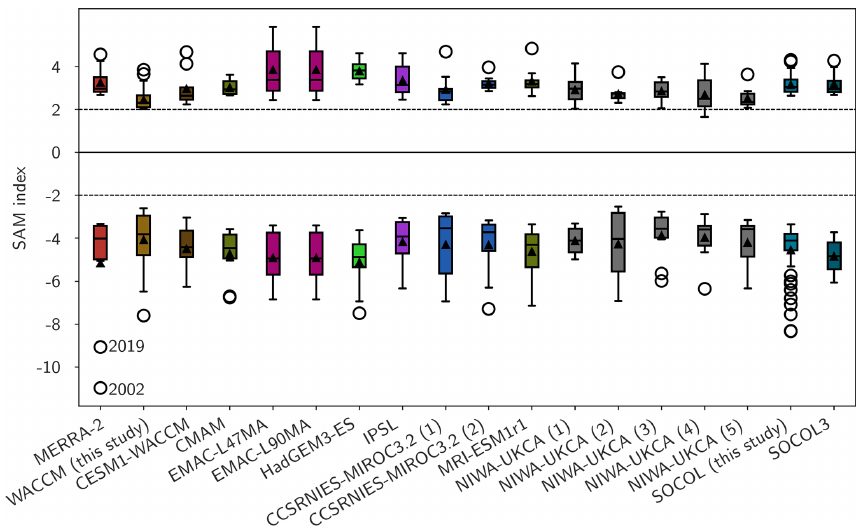
Figure A6. The 10hPa SAM index values of the lowest and highest 25% of the springtime SAM indices in MERRA-2 and the CCMI models (10 events per weak/strong category) and in the time-slice simulations of WACCM and SOCOL (50 events per weak/strong category).